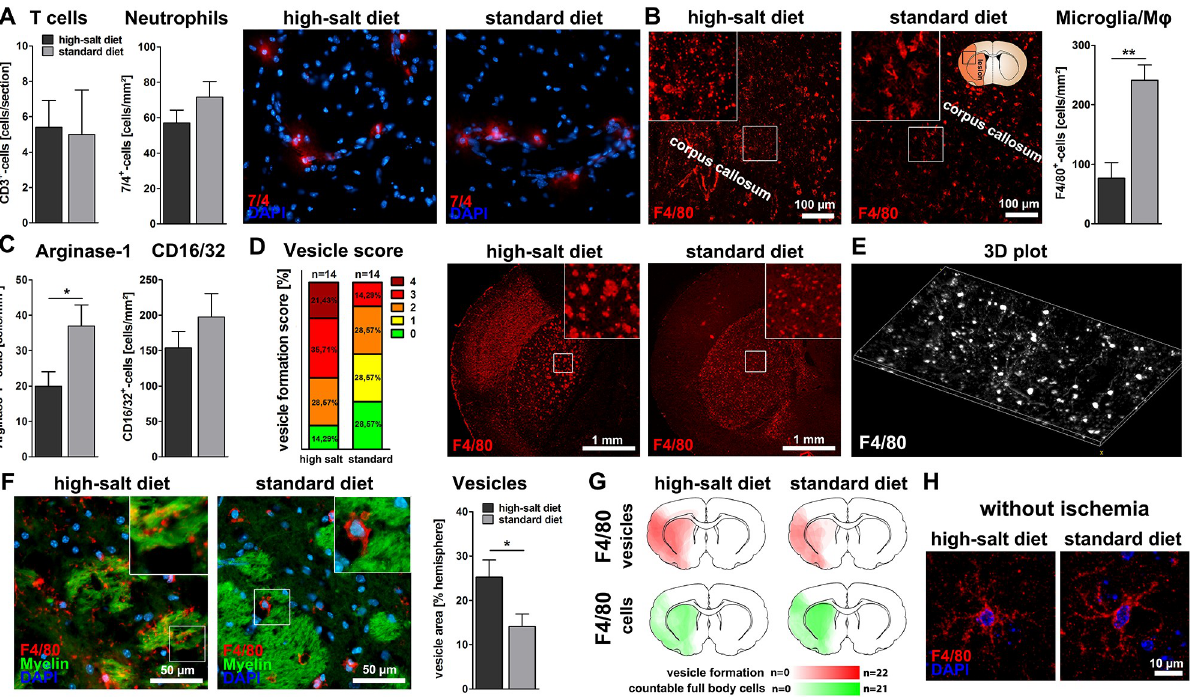
Fig 2. Sodium chloride induces vesicle formation of microglia/macrophages. (A) The total number of infiltrating 7/4 + -neutrophils and CD3 + -T cells was not affected (p = 0.16 and p = 0.61, t-test, n = 15 per group (7/4) and n = 5 per group (CD3)). (B) The number of F4/80 + -microglia/macrophages was significantly reduced after high-salt diet (p < 0.01, t-test, n = 15 per group). (C) Arginase-1-stainings illustrated a significant decrease of Arginase- 1 + -anti-inflammatory cells following high-salt diet (p < 0.05, t-test, n = 15 per group). High-salt diet did not influence the number of CD16/32 + -pro- inflammatory cells (p = 0.28, t-test, n = 16 per group). (D) Quantification of vesicle formation among F4/80 + -cells according to a previously defined score revealed increased vesicle formation following high-salt diet (score 0: No vesicles, 1: few vesicles, 2: occasional vesicle formation, 3: vesicle formation covering at least half of the striatum, 4 extreme vesicle formation, n = 14 per group). (E) Three-dimensional plot illustrating the distribution of vesicles and cytoplasmic expansions within the primary motor cortex. (F) The total area occupied by vesicles was significantly larger after high-salt diet (p < 0.05, t-test, n = 16 per group). (G) Heat maps illustrate the distribution of F4/80 + -vesicles (red) and intact F4/80 + -microglia/macrophages (green) in both experimental groups. (H) In sham operated animals, high-salt diet did not induce microglial vesicle formation.